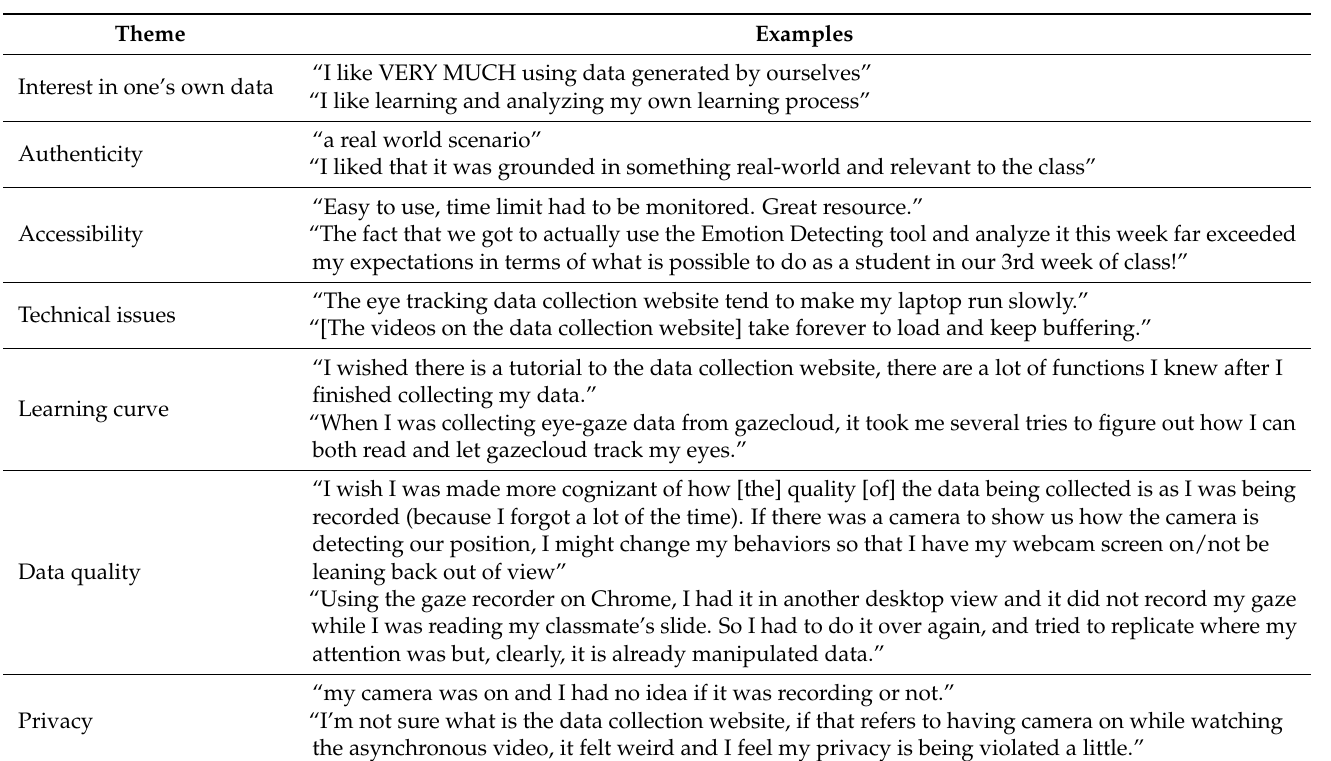
Table 2. The main themes identified from 504 response sets that were collected over the course of 12